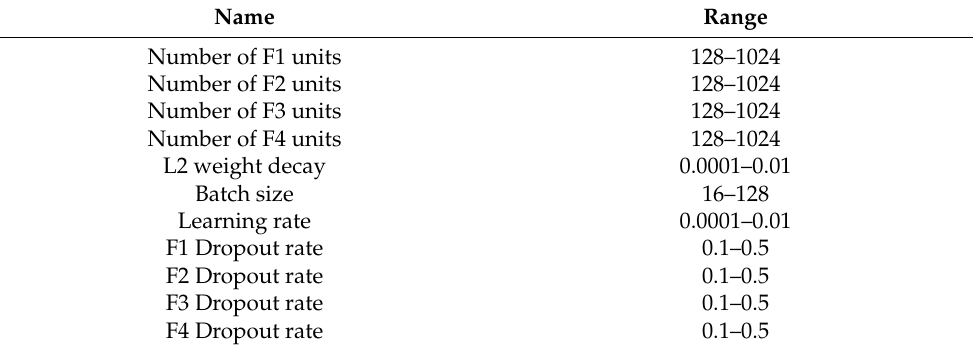
Table 5. The range of hyperparameters to be optimized on Five Flowers.